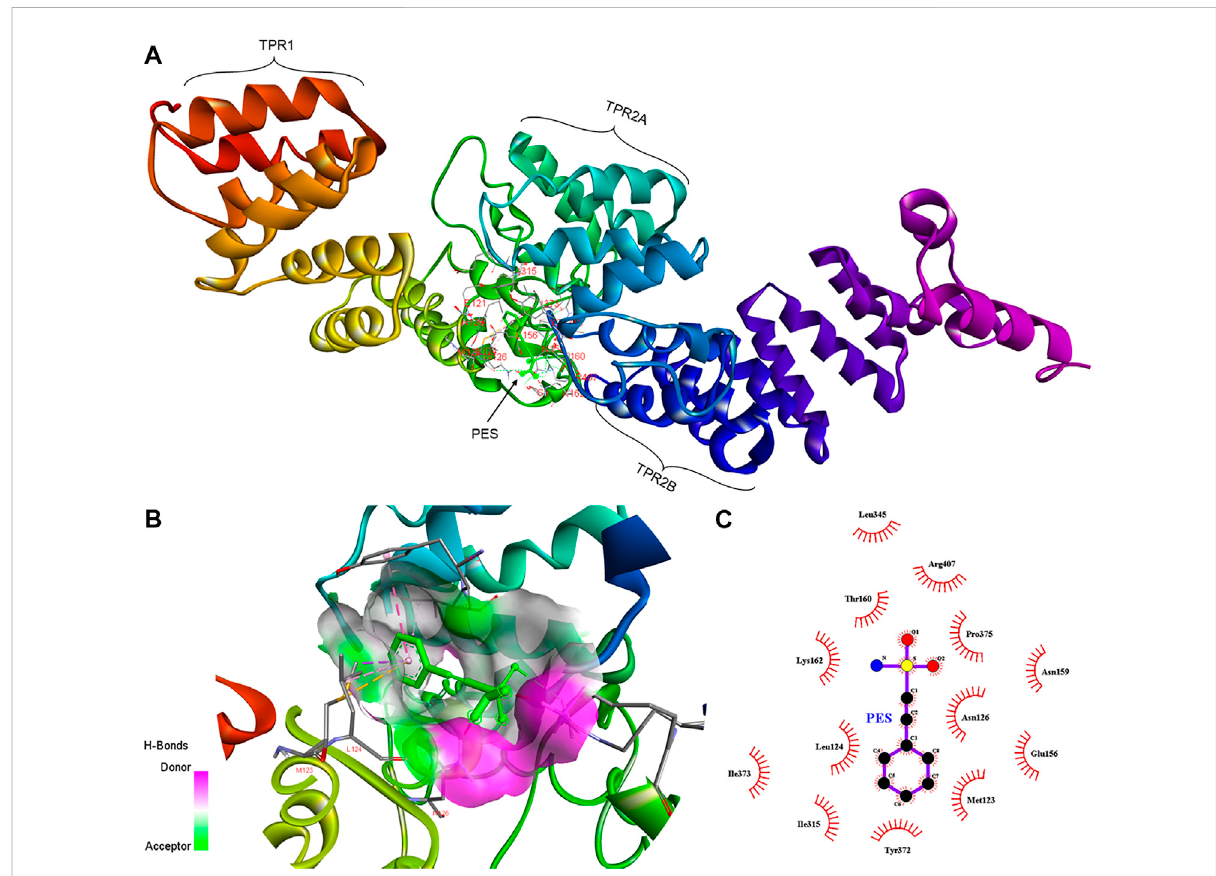
FIGURE 3 Schematic representing the interaction of PES with PfHop. (A) A docked three-dimensional model with a ribbon structure of full-length PfHop boundtoPES.Thedomainsoftheproteinarealsoshown.PESbindstotheTPR1,DP1,andTPR2Bregionsoftheprotein. (B) Surfaceandribbonviews of the docked structures, showing the residues involved in the interaction. (C) A 2D illustration of the receptor-ligand interface. PES appears to hydrogen bond with residues Arg407 on PfHop. Thus, PES forms pi-pi T-shaped interactions with Tyr372, pi-alkyl with Leu124 and Ile373, pi sigma, and pi-sulfur with Met123 of PfHop.